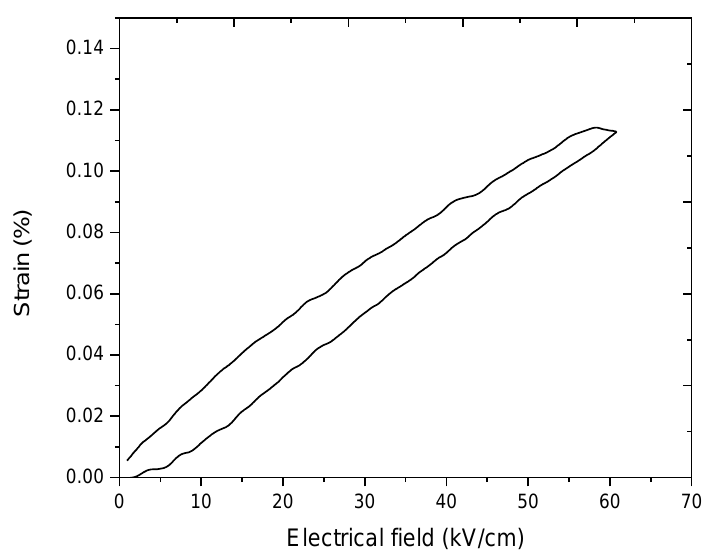
Figure 13. Unipolar electric field–induced strain of Cu Co-fired NKN sample. Table 4. Values of electrical properties of Cu co-sintered NKN ceramics.